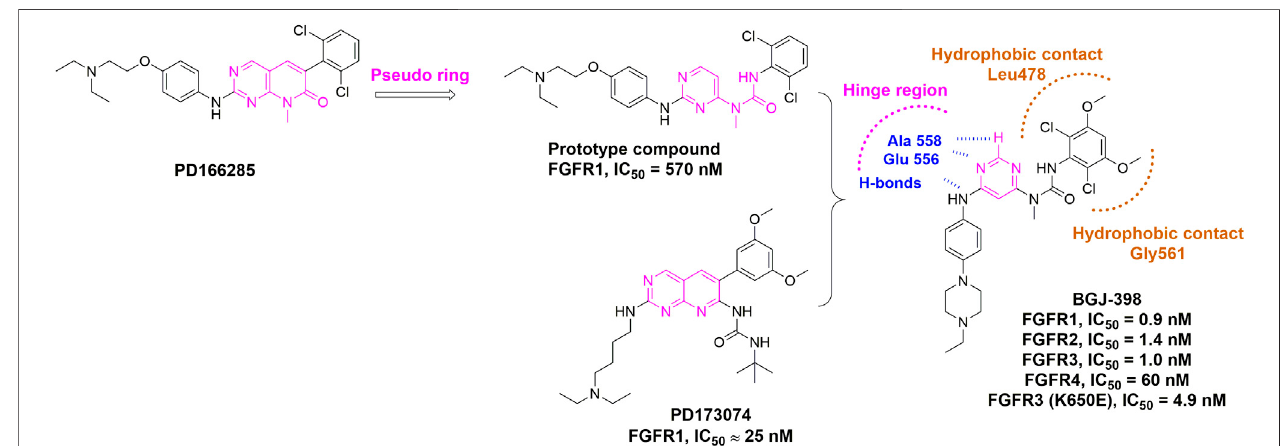
FIGURE7| Discoveryofin fi gratinib(BGJ-398) andsummaryofinteractionsofin fi gratiniband FGFR3 ATPbindingsite. H-bonds withhinge regionareindicatedby blue hashed lines. Hydrophobic interactions are outlined by hashed brown rectangle (PDB: 3TT0).